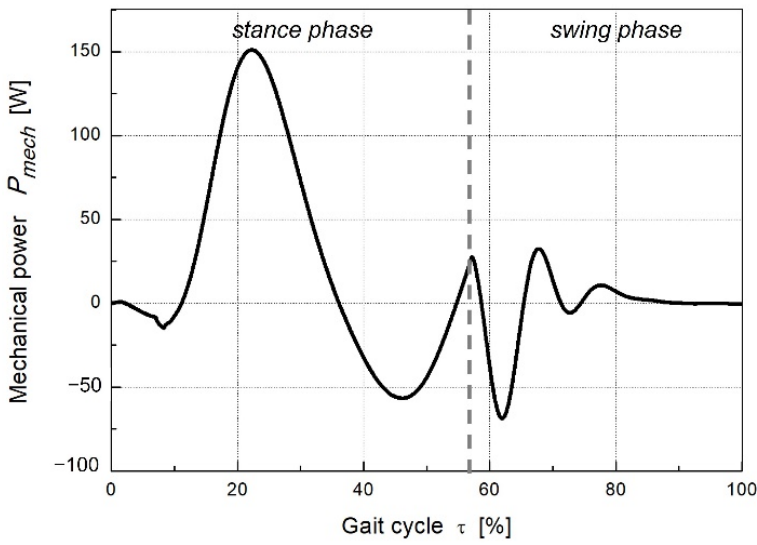
Figure 9. The course of the mechanical power.